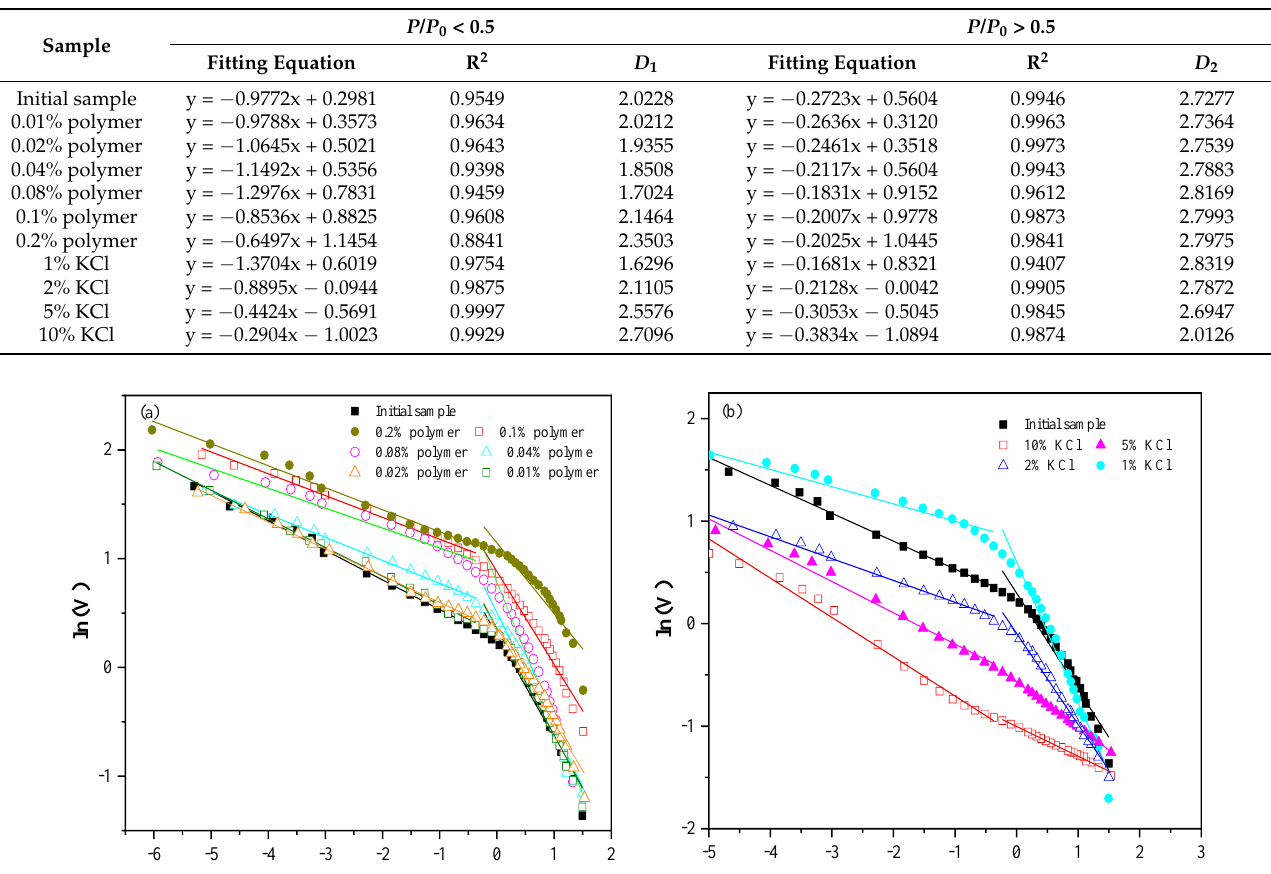
Table 3. The fractal dimension of tight sandstone derived from the fractal FHH model.